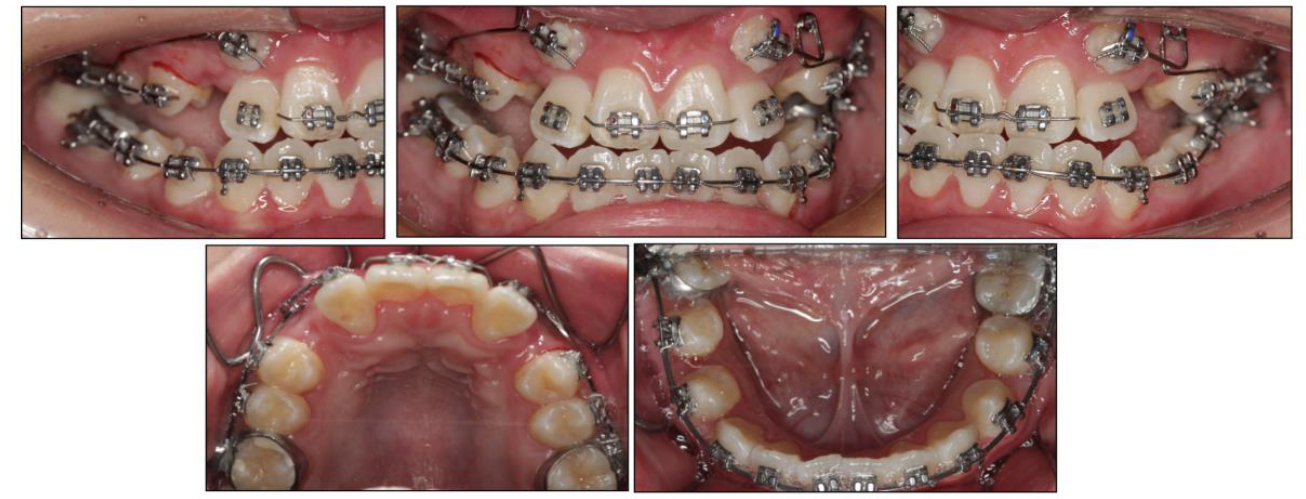
Figure 4. Tracting the impacted maxillary permanent canines with the segmental arch technique.